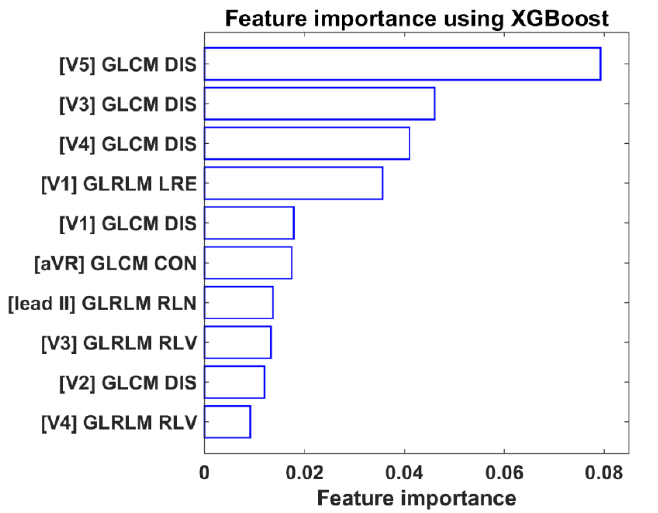
Figure 5. Top 10 most important features out of the 396 features using XGBoost. The letters in brackets denote ECG lead names: lead I, lead II, lead III, aVL, aVR, aVF, V1, V2, V3, V4, V5, V6. DIS, dissimilarity; CON, contrast; LRE, long run emphasis; RLN, run-length nonuniformity; RLV, run-length variance.